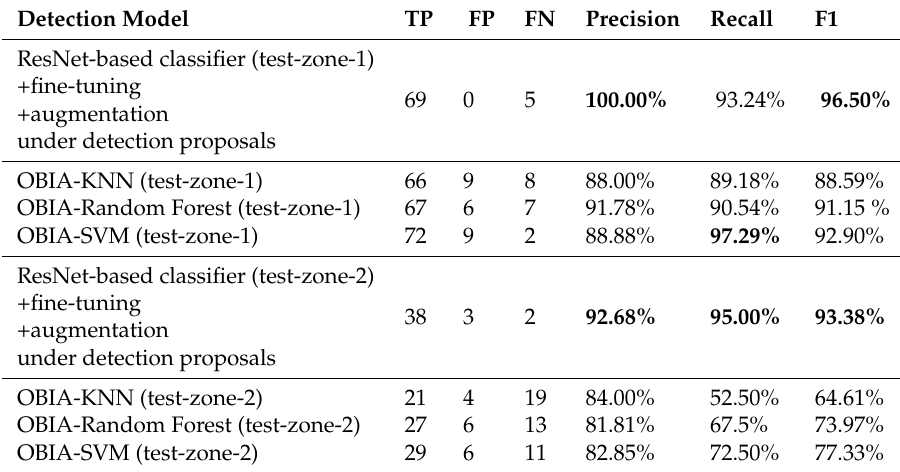
Table 4. A comparison between the best CNN-detector, ResNet-detector and OBIA, on test-zone-2, in terms of true positives (TP), false positives (FP), false negatives (FN), precision , recall and F1_measure. The highest values are highlighted in